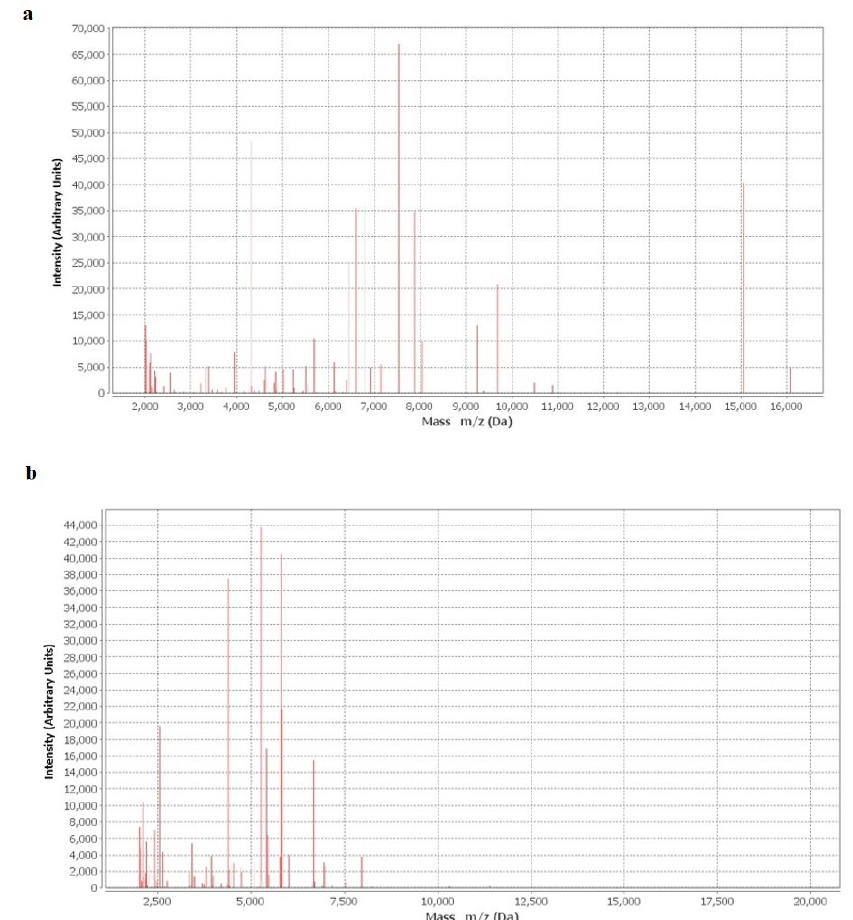
Figure 3. Mass spectra of Abiotrophia defectiva ( a ) and Finegoldia magna ( b ). Table 1. Antimicrobial susceptibility test of Abiotrophia defectiva and Finegoldia magna isolates . Abiotrophia defectiva Finegoldia magna Antimicrobial Drug